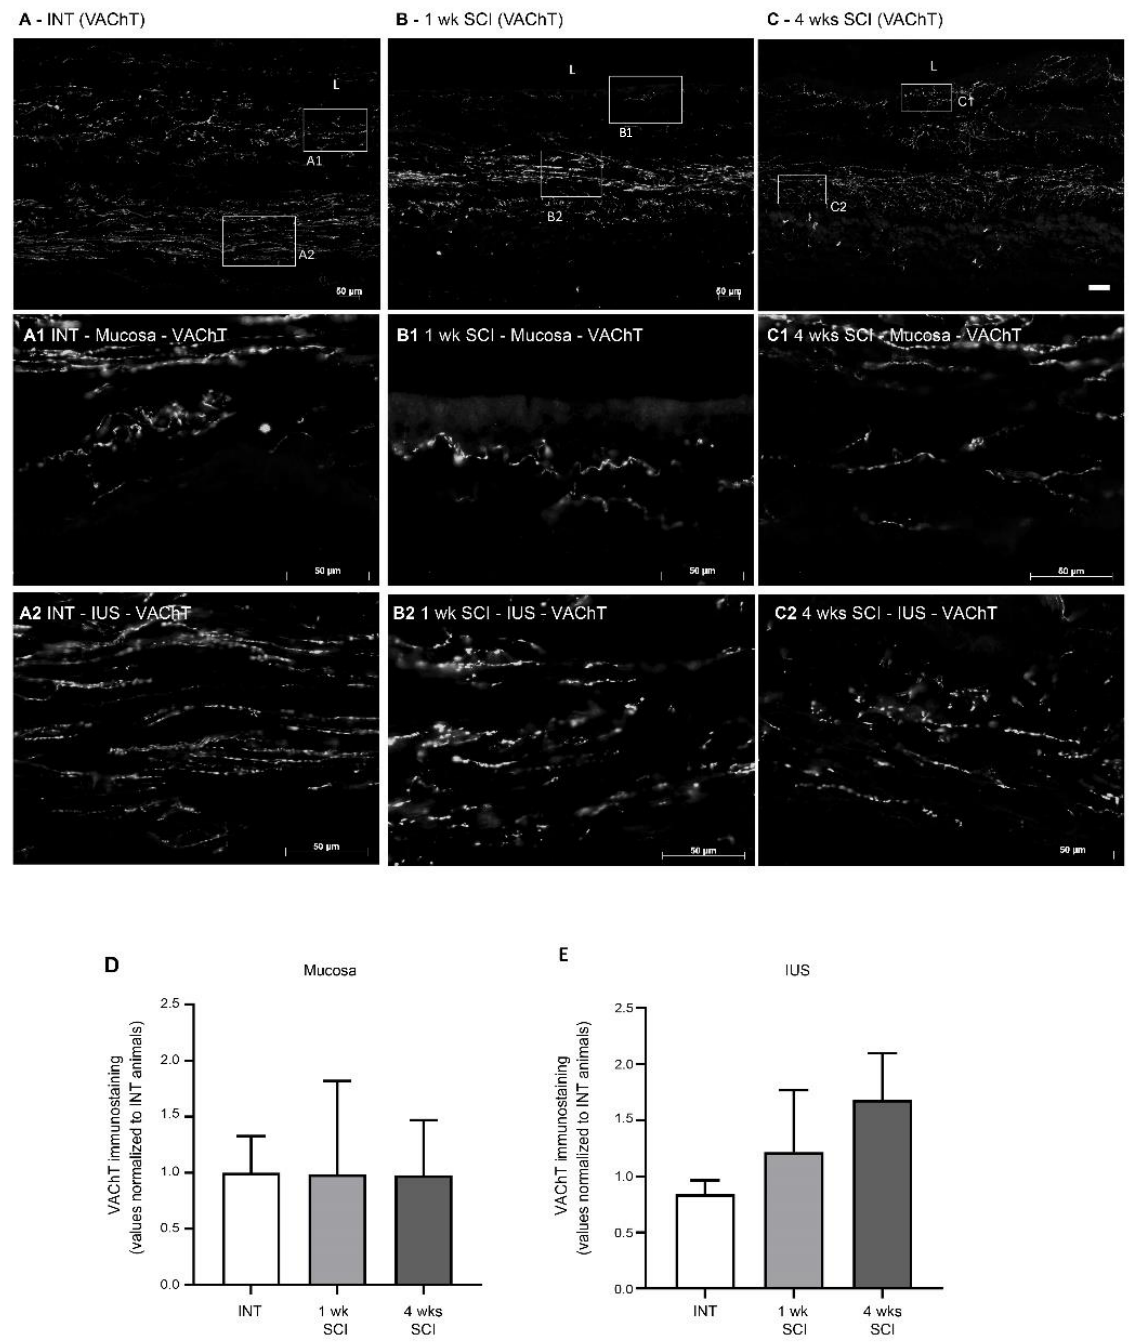
Figure 8. Immunolabeling of VAChT in the proximal urethra. Parasympathetic innervation was assessed by immunohistochemistry against the Vesicular Acetylcholine Transporter (VAChT), which stains cholinergic fibres. Intact animals ( A ) presented sympathetic fibres in the mucosa, penetrating the epithelial layer ( E ) and expanding in the lamina propria (LP) ( A1 ). Immunoreactive fibres were also present in the internal urethral sphincter (IUS) ( A2 ). A similar pattern was found in 1-week post-SCI animals ( B , B1 , B2 ). In sections from 4-weeks post-SCI animals, there was a trend towards an increase in VAChT immunoreactivity ( C ) in the mucosa and internal urethral sphincters ( C1 ; IUS, C2 , respectively). No VAChT fibres were observed in the EUS. Scale bars equal 50 μm. No significant changes were found in the mucosa ( D ) or IUS ( E ). The quantification of labelling intensity by Image J in the extension of the proximal urethra ( n = 4). One-way ANOVA followed by Tukey ’ s multiple comparison test.